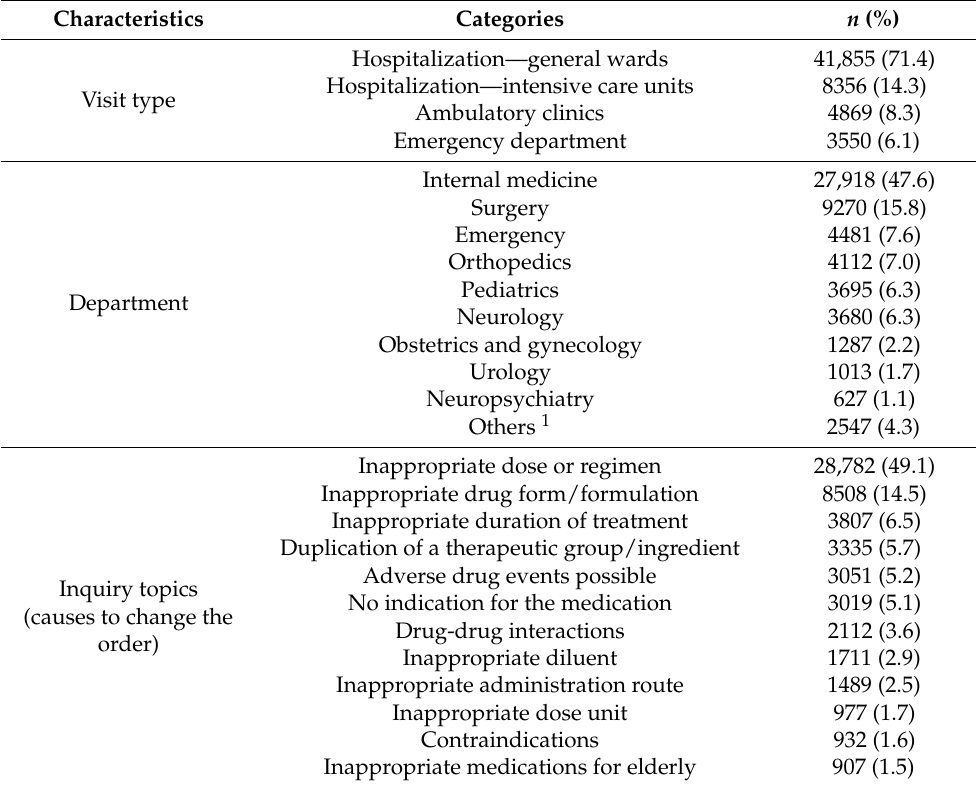
Table 1. Overall